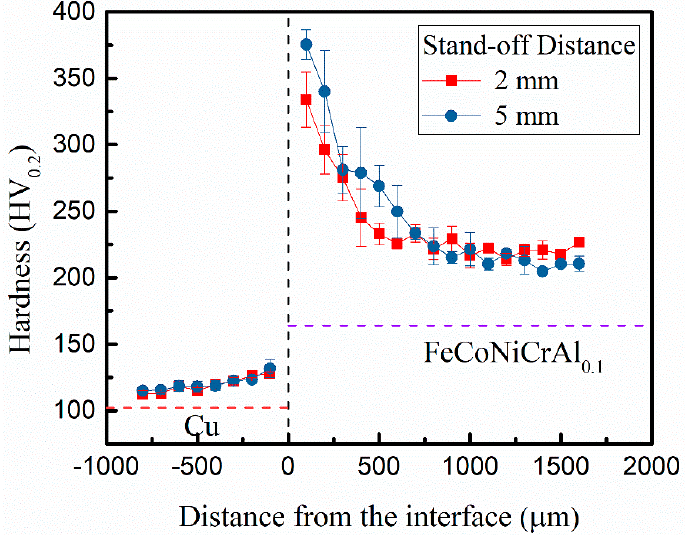
Figure 11. Hardness distribution at the interface of WCH2 and WCH5.